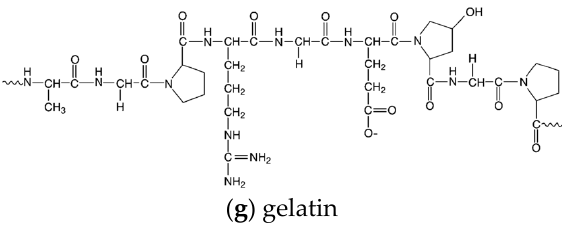
Figure 2. Chemical structures of: ( a ) chitosan, ( b ) hyaluronic acid, ( c ) poloxamer, ( d ) PLGA, ( e ) PVCL–PVA–PEG, ( f ) cetalkonium chloride, ( g ) gelatin.